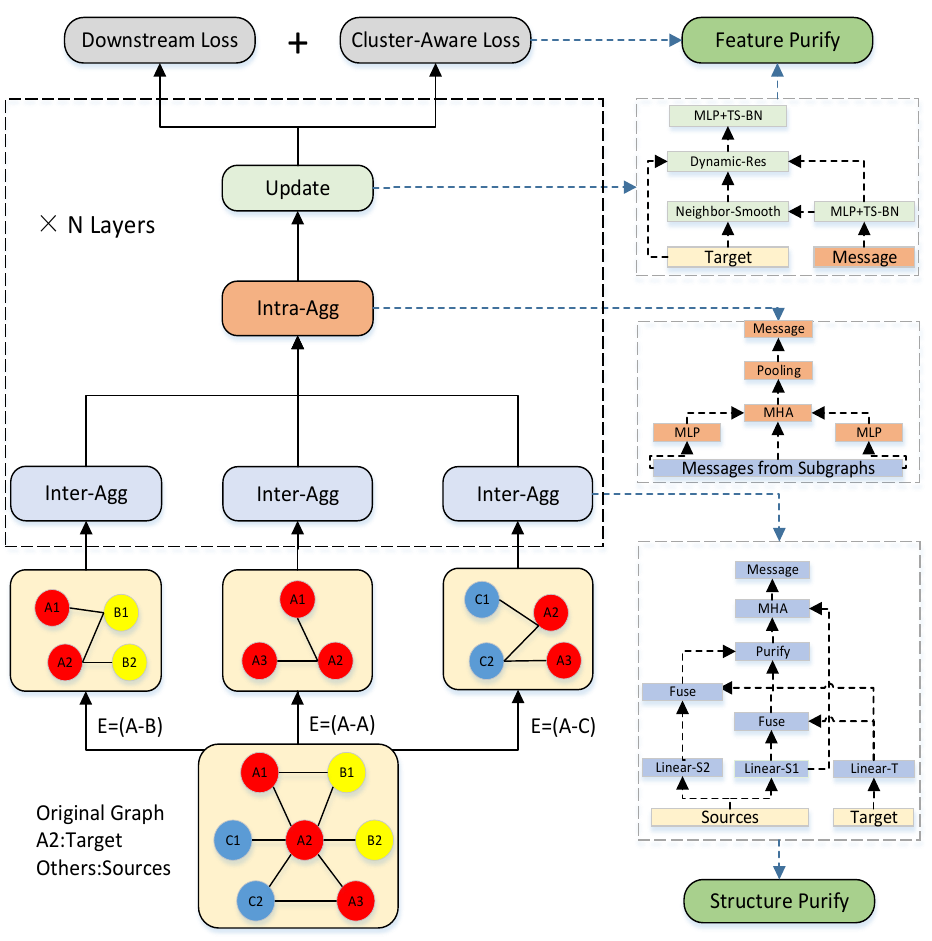
Figure 1. Our HGPN framework: (1) Subgraph Decomposition method; (2) Inter-subgraph Aggre- gation (Inter-Agg); (3) Inter-subgraph Aggregation(Intra-Agg); (4) Type-specific Update(Update); (5) Cluster-Aware Loss. “Sources” (A1, A3, B1, B2, C1, C2) and “Target” (A2) respectively refer to neighbor source nodes and central target nodes in the process of graph message passing. “MHA” denotes “Multi Head Attention”. “TS-BN” is short for “Type-Specific Batch Normalization”, while “Dynamic-Res” means “neighborhood smoothness related Dynamic Residual